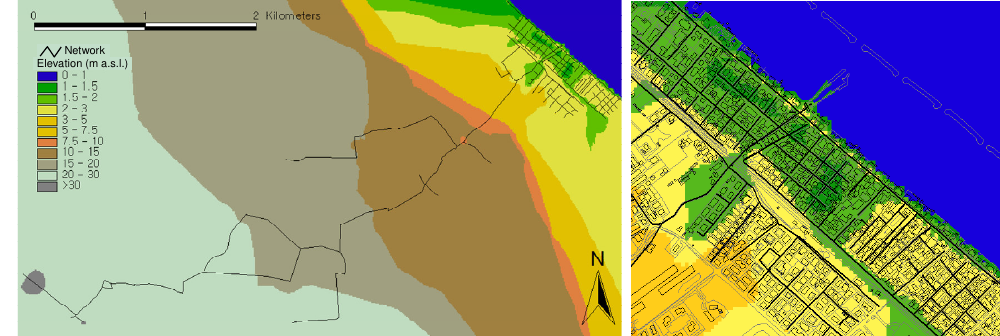
Fig. 3. Ground elevation of the entire catchment (left panel); detail of the urbanized area along the coastline (right panel).